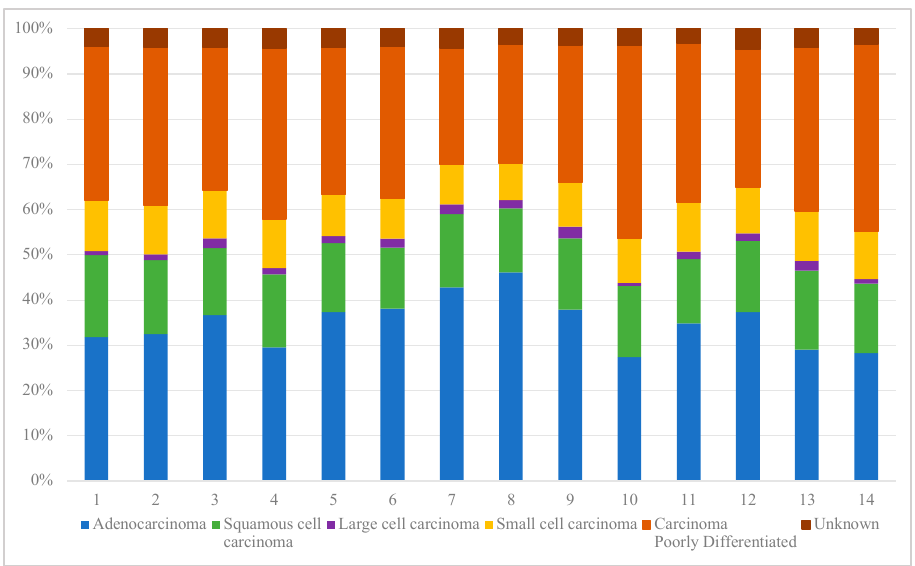
Figure 2. Proportion of histologic subtypes of lung cancer, by LHIN. This graph demonstrates the breakdown of pathologic subtype for patients diagnosed with LC in each LHIN throughout the study period. There are differences between LHINs, with some (LHIN 5–8) having higher proportions of more favorable pathology, such as adenocarcinoma with others (LHIN4, 10, 13–14) having higher proportions of less favorable pathology such as small cell, poorly differentiated and unknown.